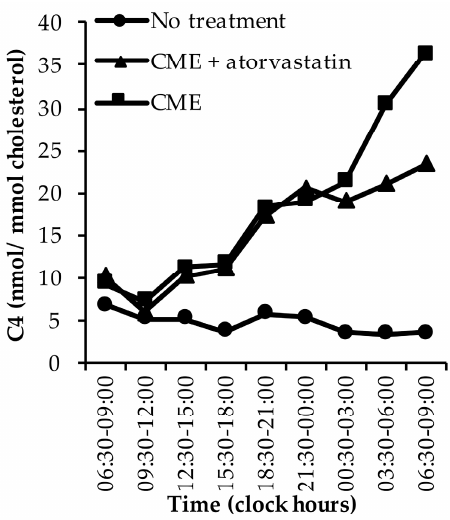
Figure 5. The diurnal rhythm of C4 levels in untreated subjects, in subjects treated with cholestyramine (CME) alone, and in subjects treated with CME plus atorvastatin [40,43]. Data are presented as medians.